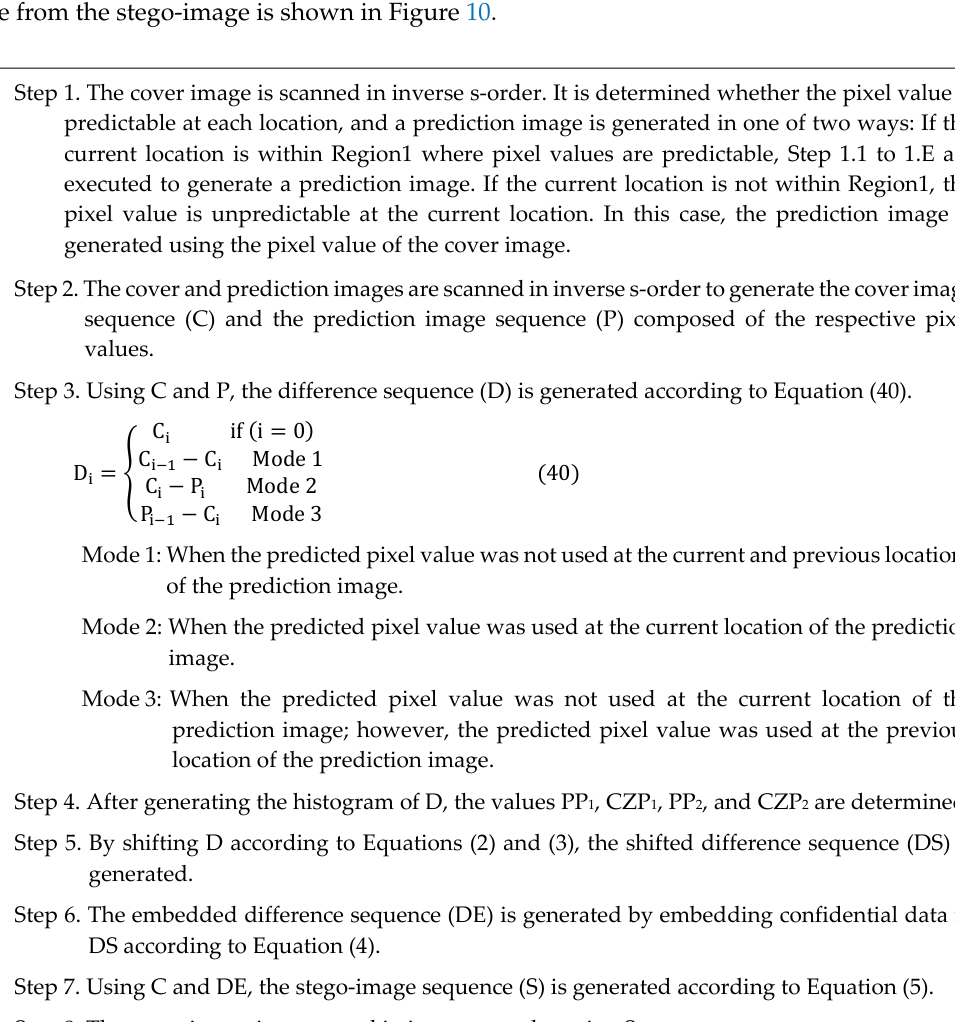
Figure 9. Confidential data embedding procedure of ARDHA.